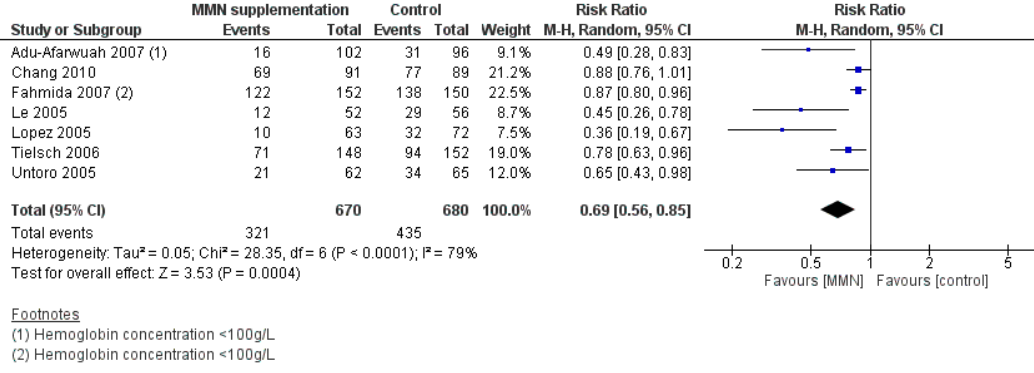
Figure 4. MMN supplementation versus placebo/no intervention (efficacy studies) on the risk of (hemoglobin concentration < 110 g / anemia (hemoglobin concentration < 110 g/L).